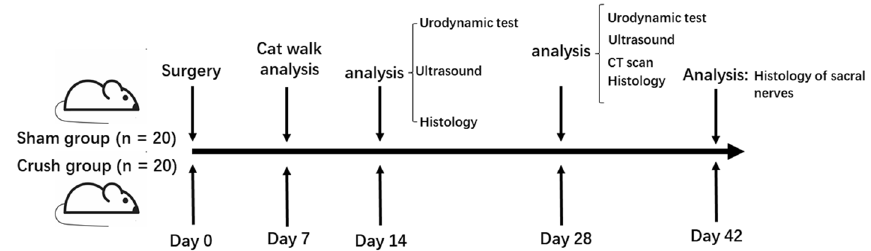
Figure 1. Study design. Experimental workflow for spinal sacral nerve injury in female rats.